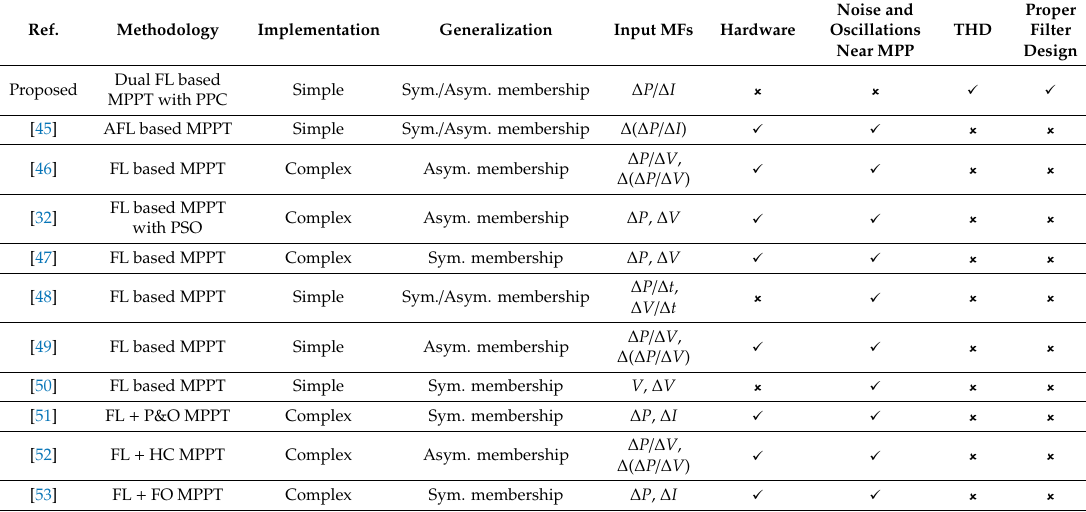
Proper Filter Design Noise and Proper Oscillatio THD Filter ns near Design MPP Proper Proper Filter Filter Design